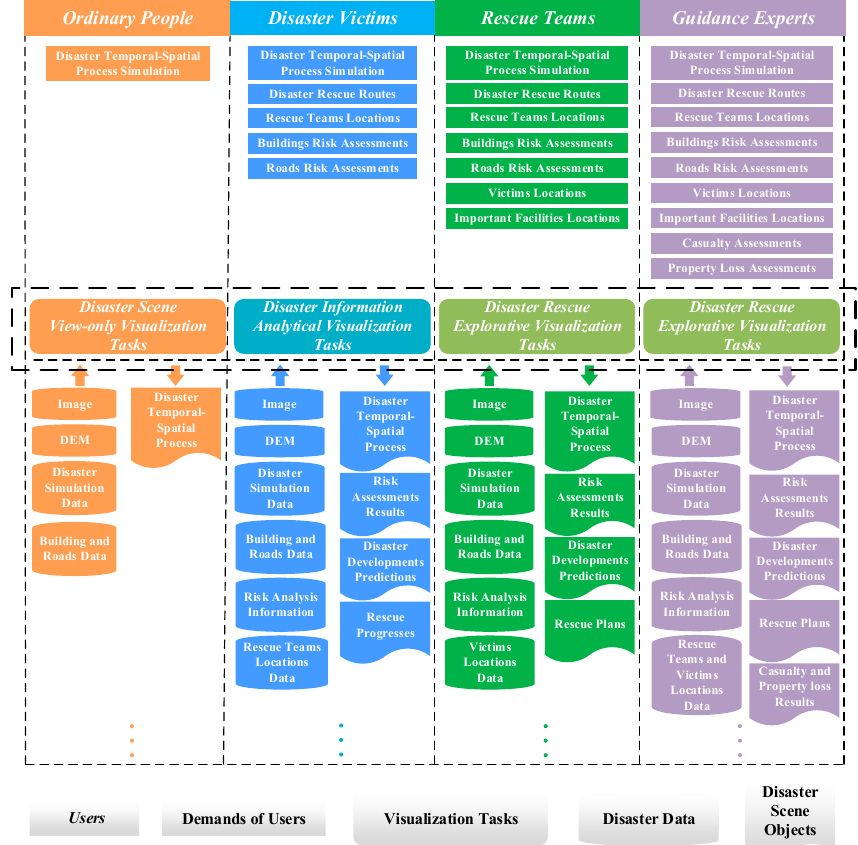
Figure 4. Relationship model of users, demands, tasks, data and scene objects in debris flow disaster emergency response. ISPRS Int. J. Geo-Inf. 2019 , 12 , x FOR PEER REVIEW8 of 16